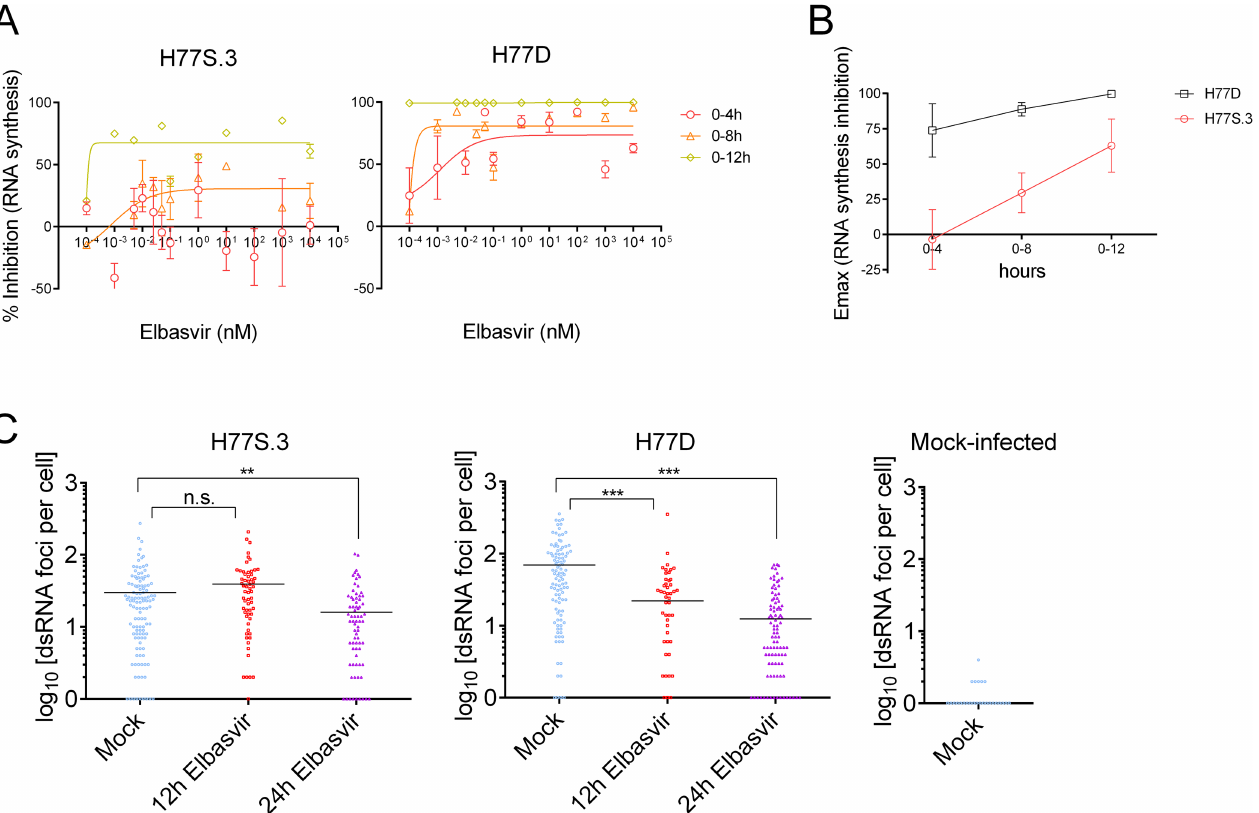
Fig 5. Slower kinetics of RNA synthesis inhibition by an NS5A inhibitor for H77S.3 compared to H77D. (A) Inhibitionof RNA synthesis measuredin cultures of Huh7.5 cells infected with either H77S.3 (left panel)or H77D (right panel)followingtreatment with elbasvir.(B) Maximum % inhibition(E max ) of RNA synthesis at different time points after additionof elbasvirto Huh7.5 cells infected with either H77S.3 or H77D. (C) Measurements of dsRNA foci per cell in Huh7.5 cells infected with either H77S.3 (left panel), H77D (middle panel)or mock-infected cells (right panel). Cells were either mock-treated or treated with 10x EC90 elbasvirfor 12 or 24 h before being fixed and stained using a dsRNA specific antibody.Foci of dsRNA per cell were quantifiedusing MetaMorph Image analysissoftware. Treatment groups were analyzedby Kolmogorov- Smirnoff test (n.s.: not significant, ** p = 0.003, *** p < 0.001).